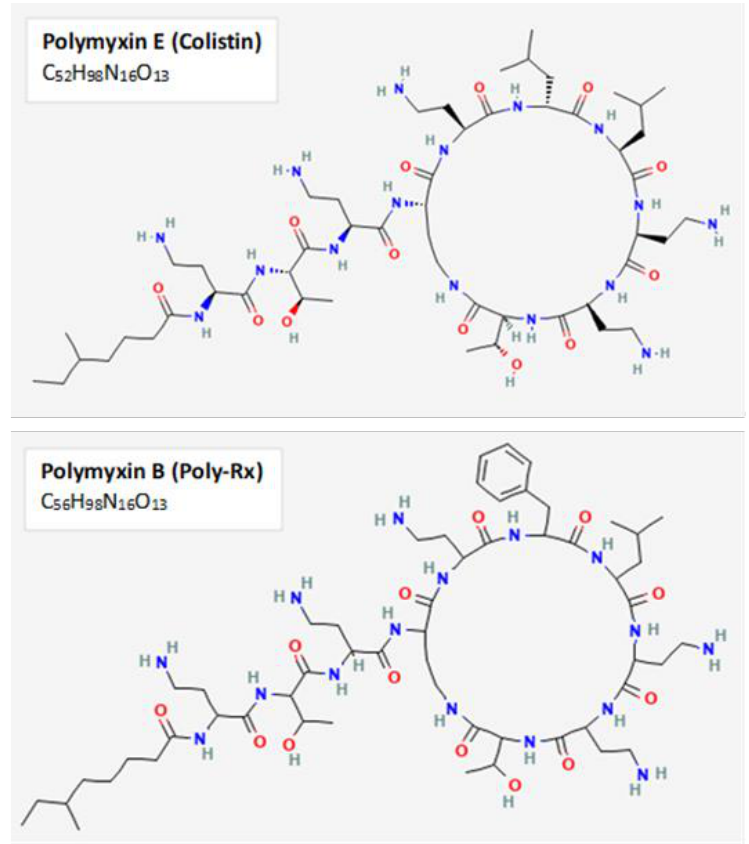
Figure 1. Chemical structure of polymyxins B and E. The primary polymyxins used clinically to treat Gram-negative infections are the cyclic polypeptides Polymyxin B and E. Both polymyxins enact their activity through binding to negatively-charged lipopolysaccharide and disruption of outer membrane permeability. The two-dimensional chemical structures and formulas for polymyxin B and polymyxin E displayed in this figure were obtained from PubChem, with CIDs 4868 and 5311054, respectively. Colistin is a cationic polypeptide that exerts its activity by binding to anionic regions of lipopolysaccharide (LPS), leading to permeabilization of the cell envelope, cell leakage, and cell death [12]. Since its displacement by other antimicrobials four decades prior, colistin has shown significant activity against KP, P. aeruginosa , A. baumannii , and other Gram-negative pathogens with low initial resistance levels [13]. However, with increased use in the clinical space, rates of colistin resistance have been on the rise through several main mechanisms, including chromosomal mutations in genes responsible for disrupting the cationic charge of LPS (PhoP/PhoQ and PmrA/PmrB two-component regulatory systems) and MgrB, a transmembrane regulator of PhoP/PhoQ signaling, as well as plasmid-mediated colistin resistance ( mcr-1-10 ) [14,15]. It has also been shown that increased production of